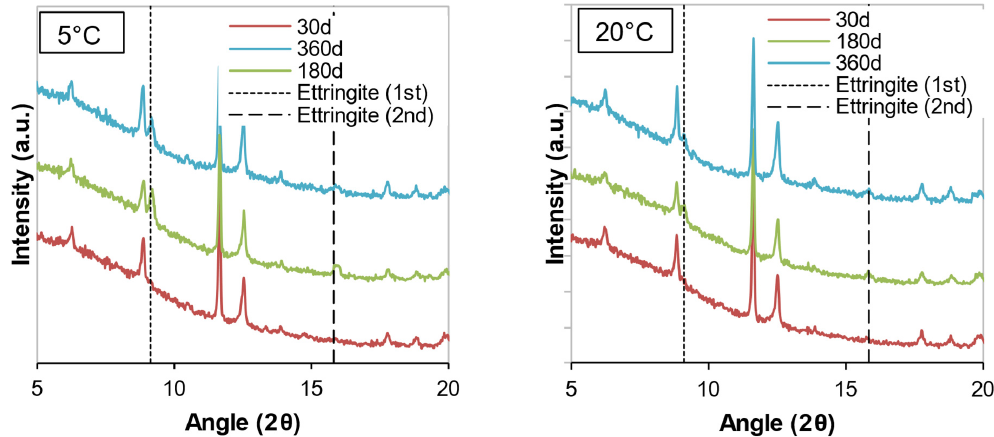
Figure 13. Diffractograms of Sg + S + C + W2 at different temperatures.